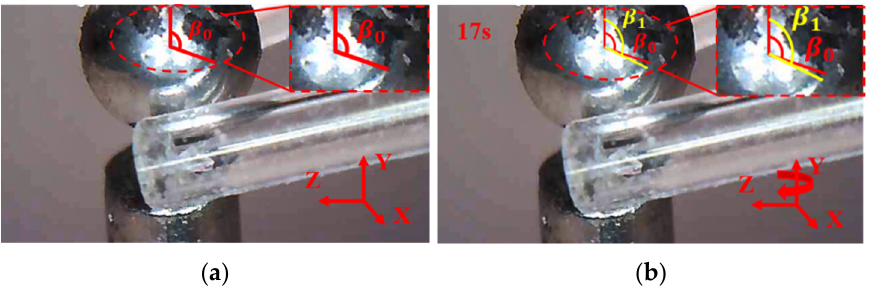
Figure 18. Manipulation of a micro ball: ( a ) Initial state; ( b ) the micro gripper tips are moved to enclose the micro ball; ( c ) the micro ball is gripped; ( d ) the micro ball is moved to a distance; ( e ) the micro ball is rotated about axis X; ( f ) the micro ball is released.